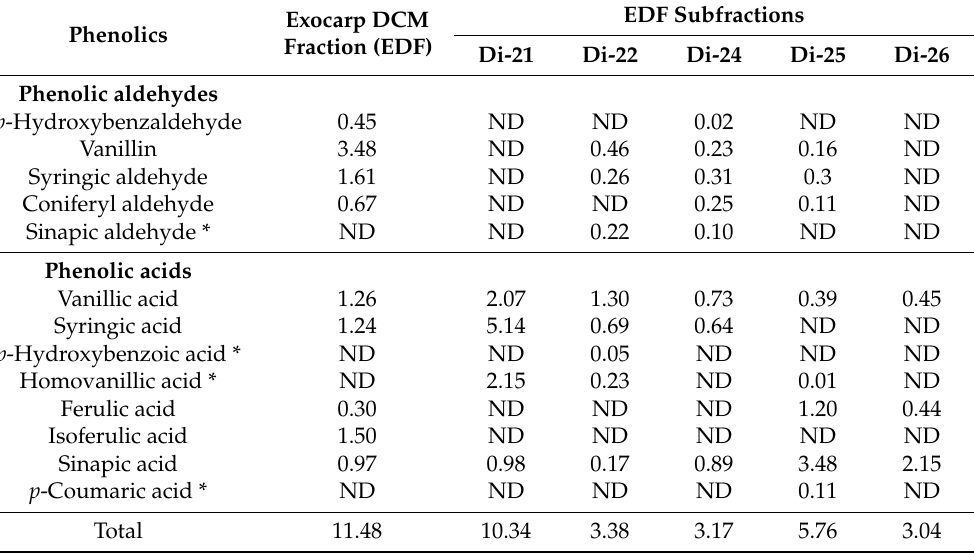
Table 5. Area percentage (%) of phenolics in exocarp DCM fraction (EDF) and subfractions through GC-MS